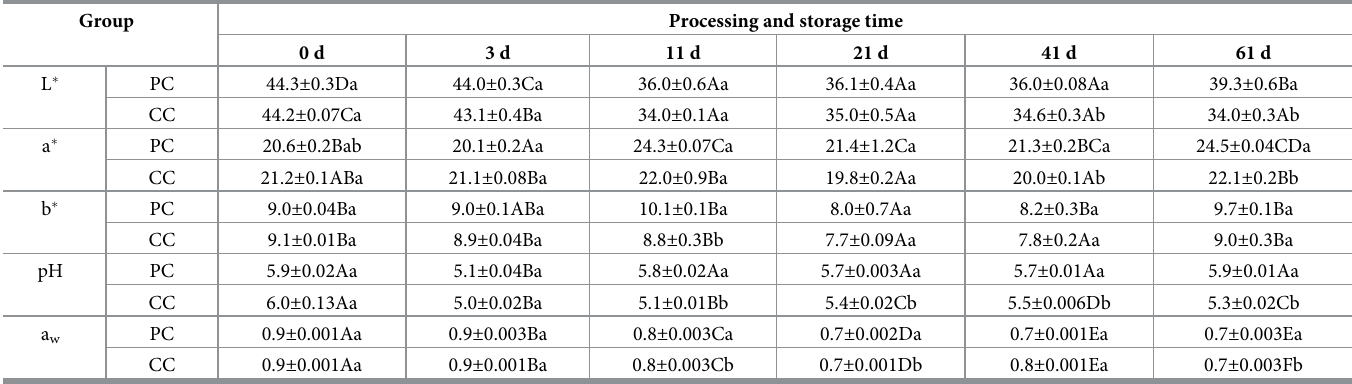
Data in the table were the mean ± S.D. of the three fermented sausage per experimental group of three independent experiments. Different capital letters indicated significant differences over time within the same group ( P < 0.05) and different lowercase letters indicated significant differences between groups at the same time ( P < 0.05), while the same letter indicated no significant difference ( P > 0.05). PC: pig casing, CC: collagen casing; L � : luminance value; a � : redness value; b � : yellowness value; a w : water